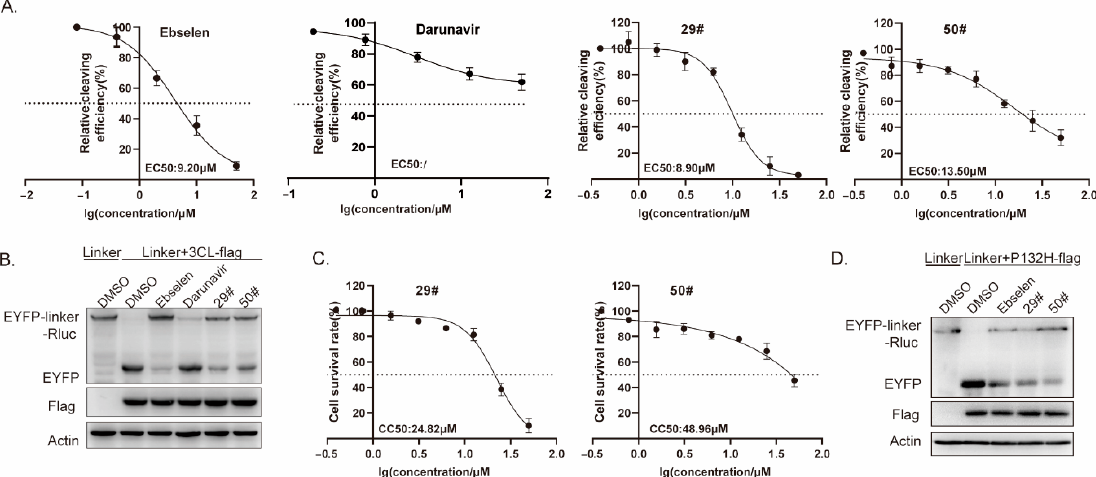
Figure 6. Effect of hits on 3CL Omicron variants. ( A ) HEK293T cells were co-transfected with the 3CL-flag and EYFP-linker-Rluc plasmid DNA. At 12 h post-transfection, the cells were re-seeded in 96-well plates (10 4 /well) and treated with the serially diluted hits. After 36 h, the BRET ratio was measured. ( B , D ) HEK293T cells (4 × 10 5 ) were co-transfected with the 3CL-flag(or P132H-flag) and EYFP-linker-Rluc plasmid DNA. At 12 h post-transfection, the cells were treated with the hits (20 µ M). After 48 h post-transfection, cells were collected for a Western blot. ( C ) CC 50 values in the cells